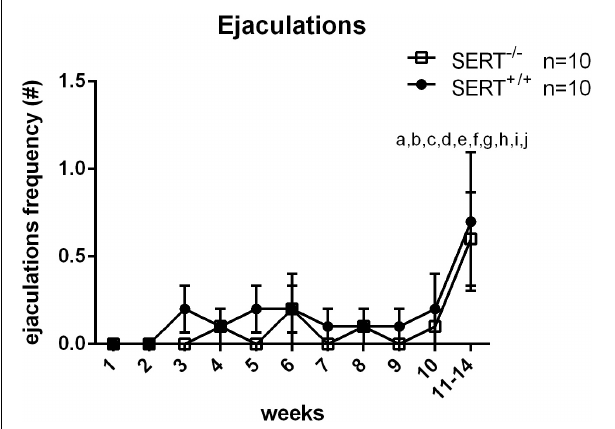
FIGURE 2 | Mean ejaculation frequencies ( ± SEM) over 10 weeks of training of male Wistar rats of group two (selection for slow ejaculating rats). Added is also the mean ± SEM of the saline data from S15535 experiment (week 11–14). a: significantly different ( p < 0.05) from week 1; b: significantly different ( p < 0.05) from week 2; c: significantly different ( p < 0.05) from week 3; d: significantly different ( p < 0.05) from week 4; e: significantly different ( p < 0.05) from week 5; f: significantly different ( p < 0.05) from week 6; g: significantly different ( p < 0.05) from week 7; h: significantly different ( p < 0.05) from week 8; i: significantly different ( p < 0.05) from week 9; j: significantly different ( p < 0.05) from week 10; *significantly different ( p < 0.05) from SERT + / + . Detailed statistical analyses are provided in Table 3